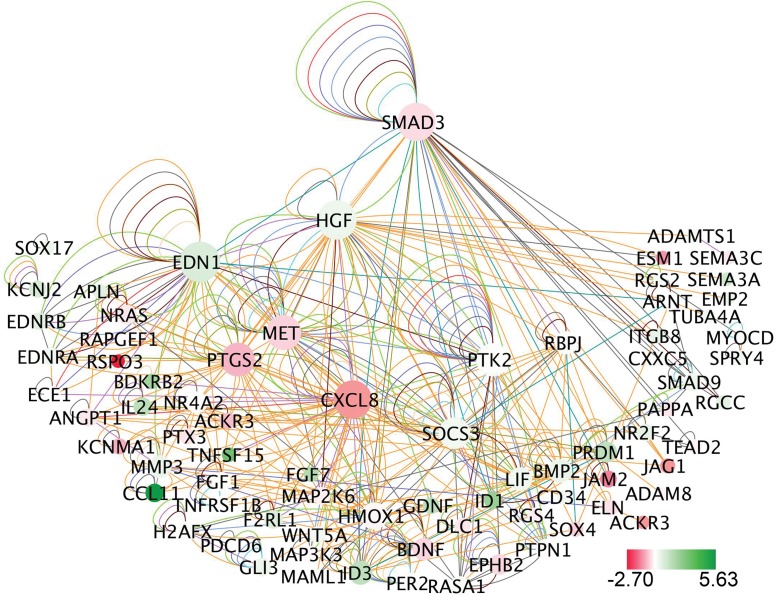
SMAD3 “vascular development” network built with differential gene expression data from siSMAD3 RNAseq studies in HCASMC.Interaction of the network nodes identified through enrichment of differentially expressed genes in functionally annotated categories was visualized with Cytoscape. Node color was mapped to log2 fold-change with red representing genes that are downregulated along with SMAD3 and green representing genes that are upregulated, and node size mapped to the number of interactions with other genes. Edges are colored to distinguish types of interactions: bright green edges represent activation, neon carrot—expression, red—inhibition, purple—localization, blue—molecular cleavage, malibu light blue—phosphorylation, persian green- protein-DNA interactions, dove grey—protein-protein interactions, saddle brown—reaction, lonestar red—regulation of binding, dusty gray—transcription, peach orange—translocation, aqua blue—ubiquitination.